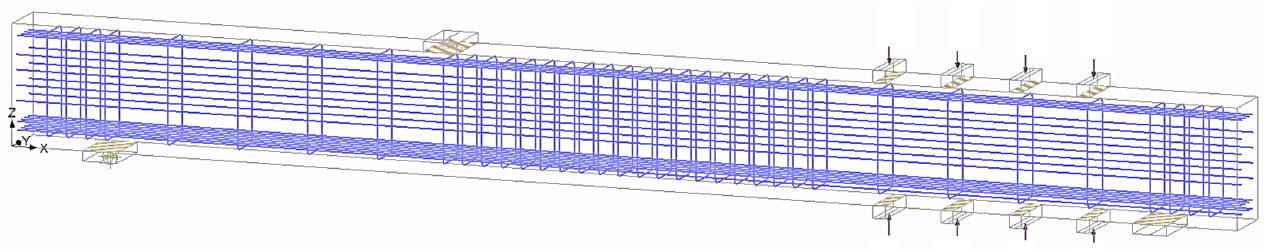
Figure 10. Flexure and shear reinforcement in the FEM. Table 7. Mesh information of the FEM.